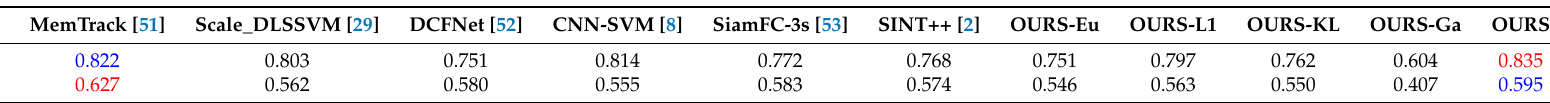
Table 2. The precision rate (PR) and success rate (SR) of our tracker and recent state-of-the-art trackers on OTB-100. Eu, Euclidean distance; Ga, Gaussian distribution. The red number is the best result and blue indicates the second.